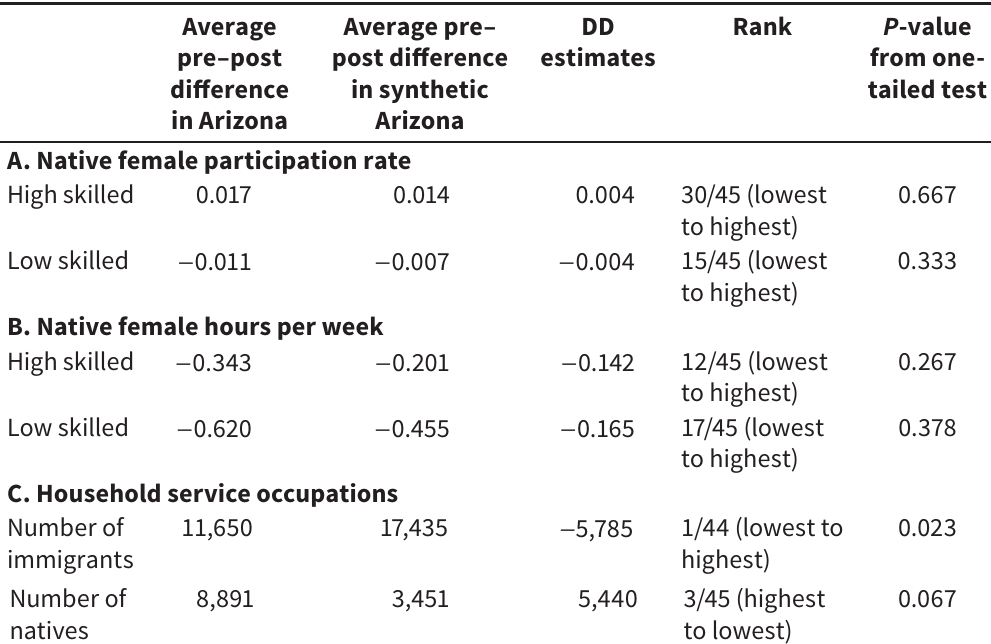
Sensitivity check – excluding